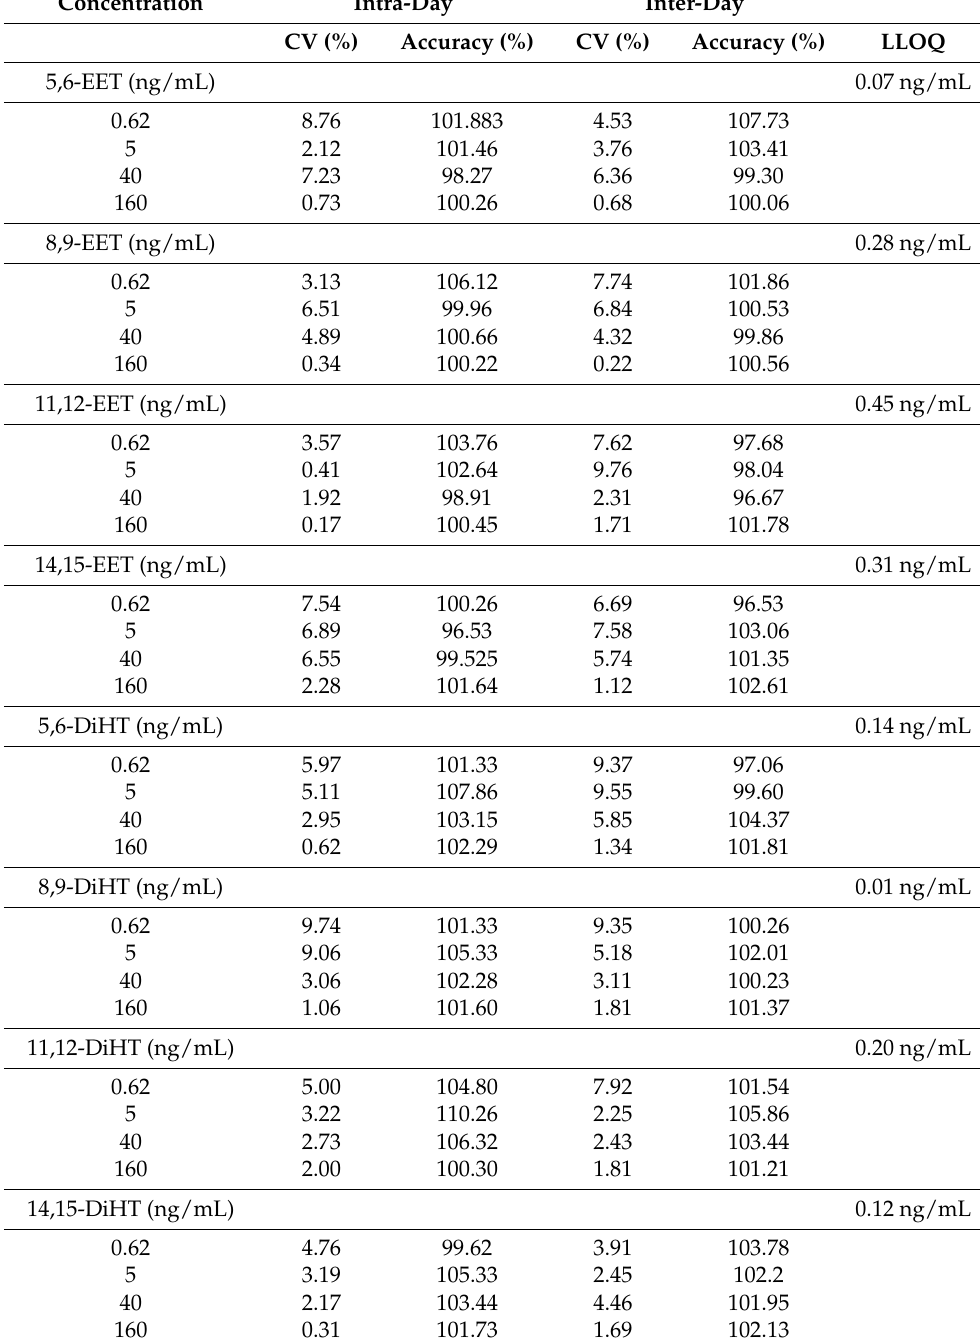
Table 4. Inter- and intra-day precision and accuracy of ArA